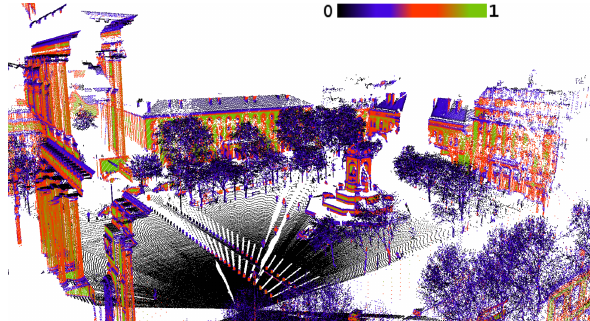
Figure 1: Cutting of the trajectory in different control time T c .